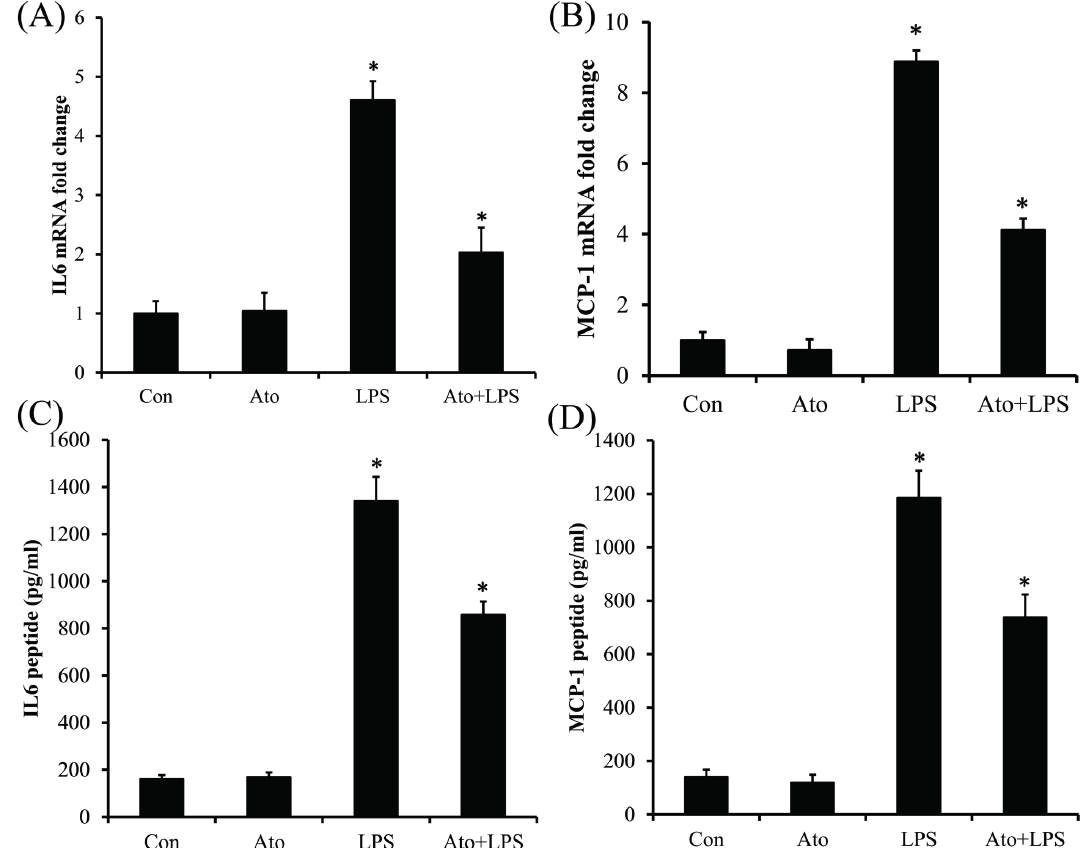
FIGURE 3 - The effects of atorvastatin on LPS-induced IL-6 and MCP-1 expression in HCAECs.